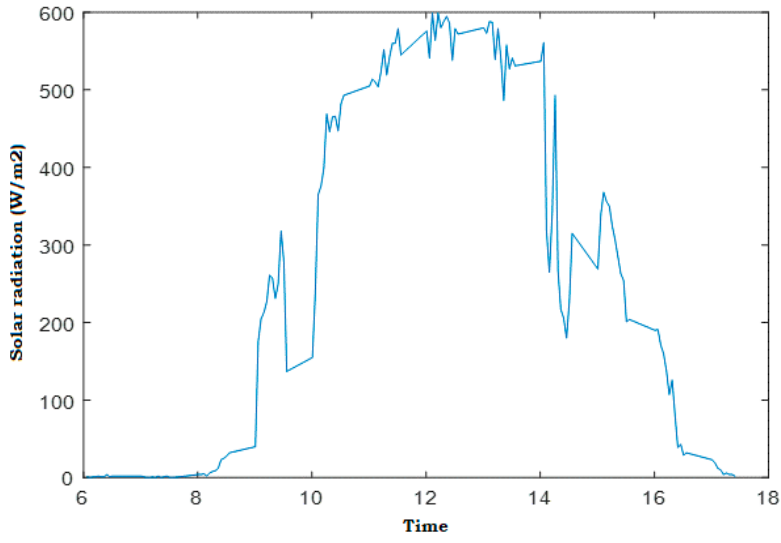
Figure 2. Solar radiation evolution in W/m 2 for a winter day.